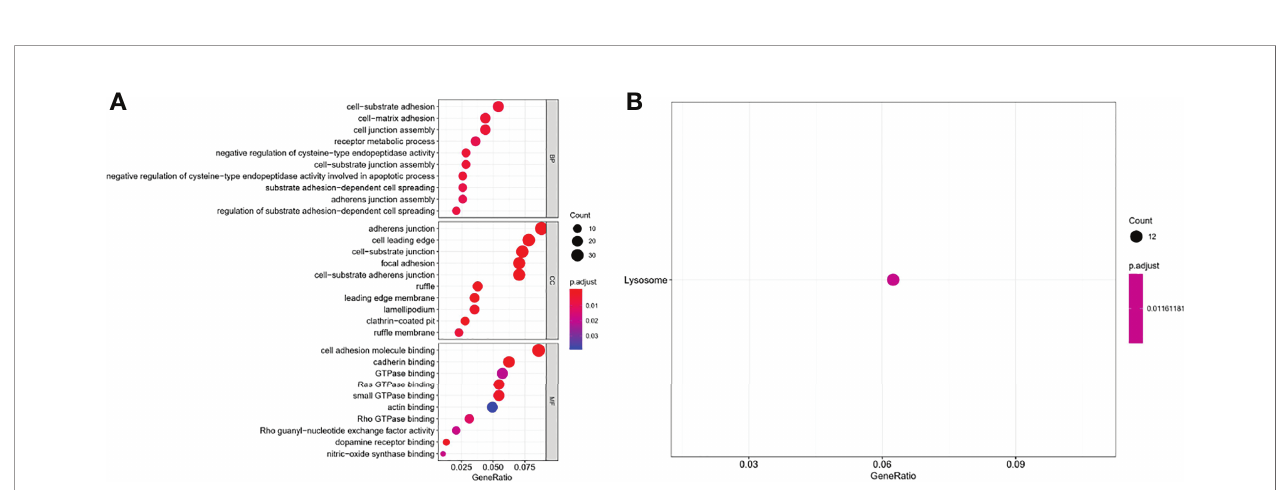
FIGURE 4 | GO and KEGG pathway enrichment analysis of DEAS events. (A) GO analysis. (B) KEGG pathway enrichment